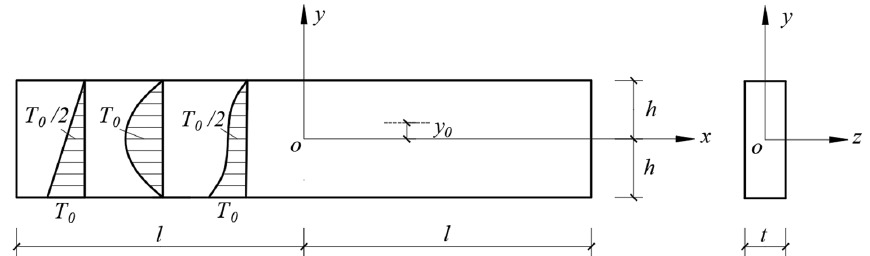
Figure 2. Sketch of a bimodular bar under three temperature rise modes, in which T 0 is the highest rise and y 0 is the location of neutral axis. rise and y 0 is the location of neutral